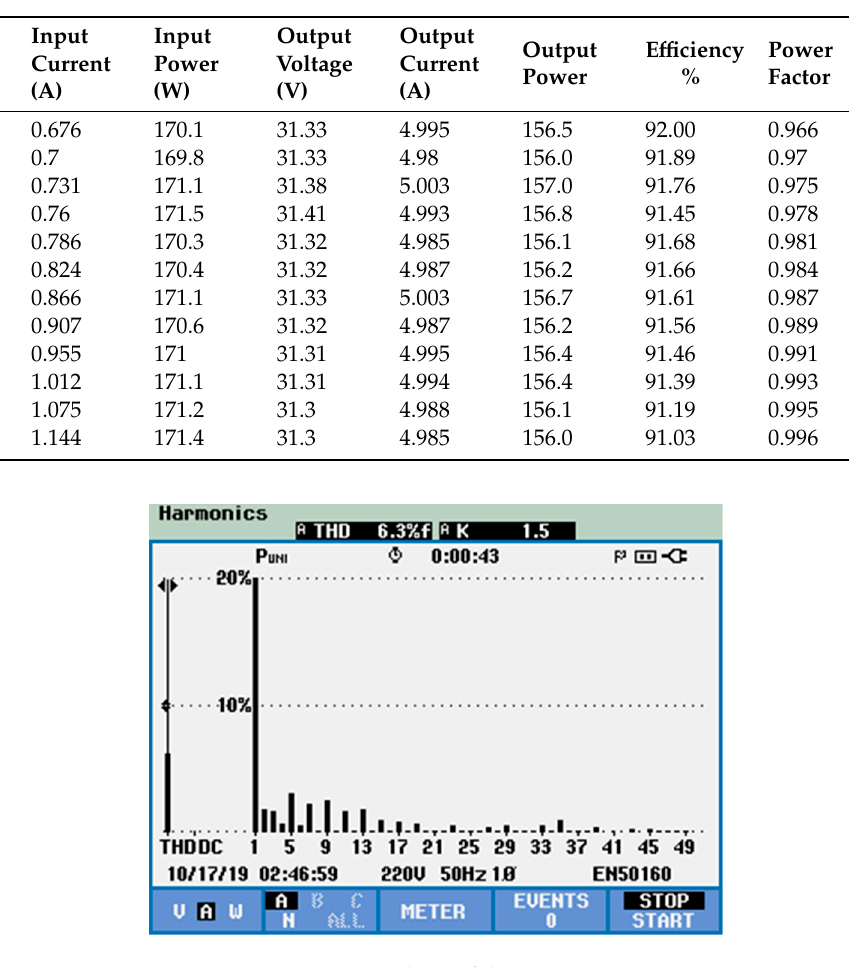
Figure 21. FFT analysis of the input current. Table 7. Experimental results of input/output performance of 150 W two ‐ stage LED driver.